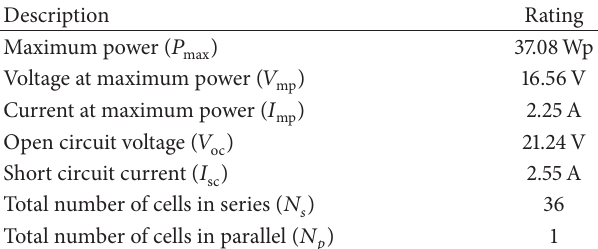
Table 1: Electrical characteristic data of Solkar 36 W PV